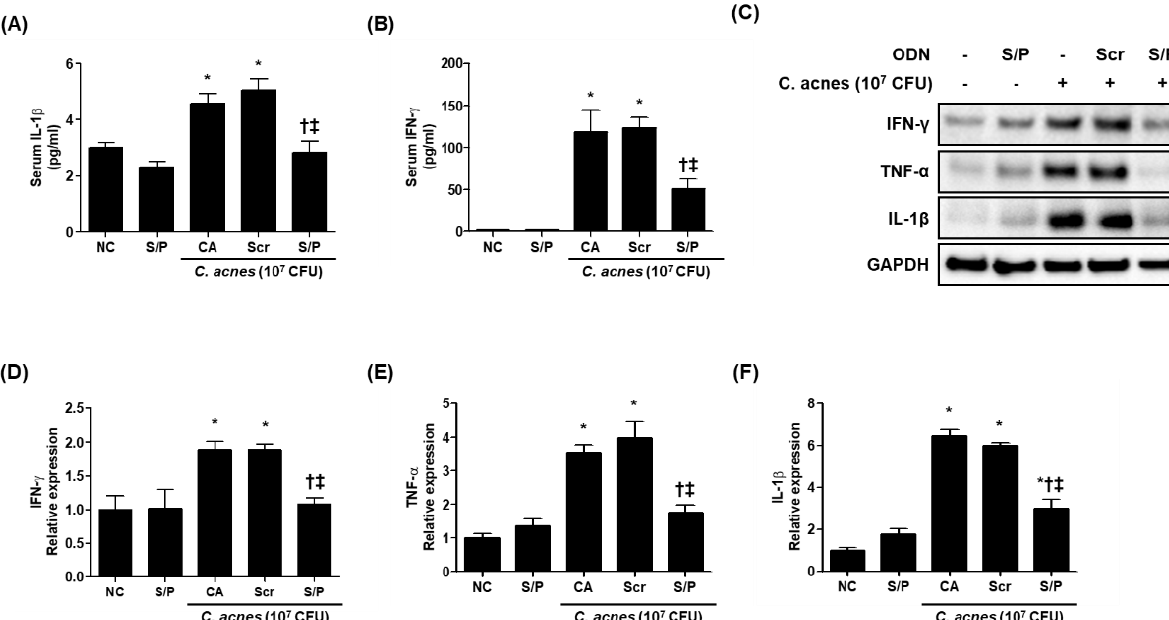
Figure 4. The SREBP/PPAR chimeric decoy ODN suppressed C. acnes -induced activation of pro- inflammatory cytokines. ELISA results demonstrating that the SREBP/PPAR decoy ODN suppressed the C. acnes -induced increased serum levels of ( A ) IL-1 β and ( B ) IFN- γ . ( C ) Representative Western blot analysis results showing that the SREBP/PPAR decoy ODN inhibited the C. acnes -induced activation of pro-inflammatory cytokines. ( D – F ) Graphs showing the quantitative signal intensities of IFN- γ , TNF- α , and IL-1 β after normalization with GAPDH. The results are expressed as mean ± SEM. * p < 0.05 compared with the NC. † p < 0.05 compared with the CA. ‡ p < 0.05 compared with the CA+Scr. Scale bar = 50 µ m. NC, normal control; S/P, normal control treated with SREBP/PPAR chimeric decoy ODN; CA, group injected with living C. acnes ; CA+Scr, group injected with living C. acnes and treated with Scr decoy ODN; CA+S/P, group injected with living C. acnes and treated with SREBP/PPAR chimeric decoy ODN.